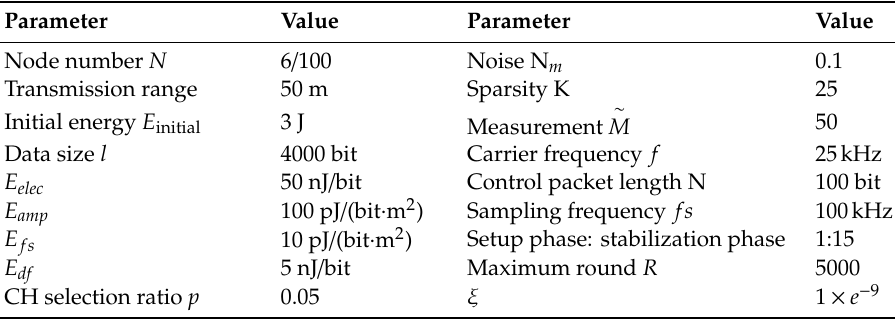
Table 1. Simulation